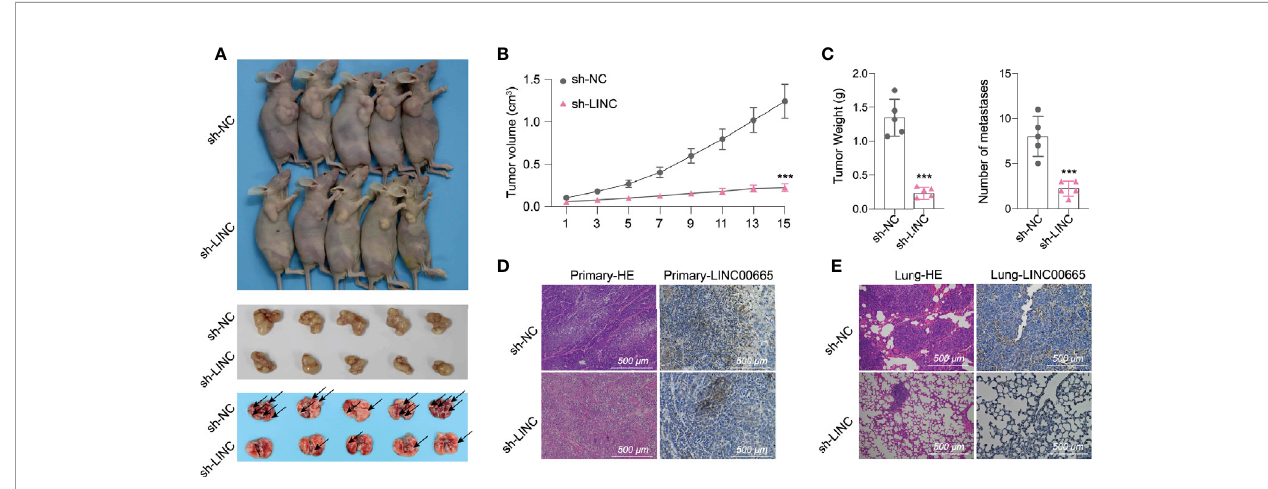
FIGURE 3 | LINC00665 promotes tumor progression in vivo. (A – C) A549 cells transfected with sh-LINC00665 or sh-NC were subcutaneously injected into the armpit of a nude mouse (1×10 7 cells per mouse, n = 5 each group). The volume, weight of subcutaneous xenograft tumors, and the number of lung metastasis of LUAD cells isolated from nude mice. (D, E) HE and LINC00665 FISH of xenograft or lung metastasis tumor after transfected with si-LINC00665 or sh-NC. ***p <